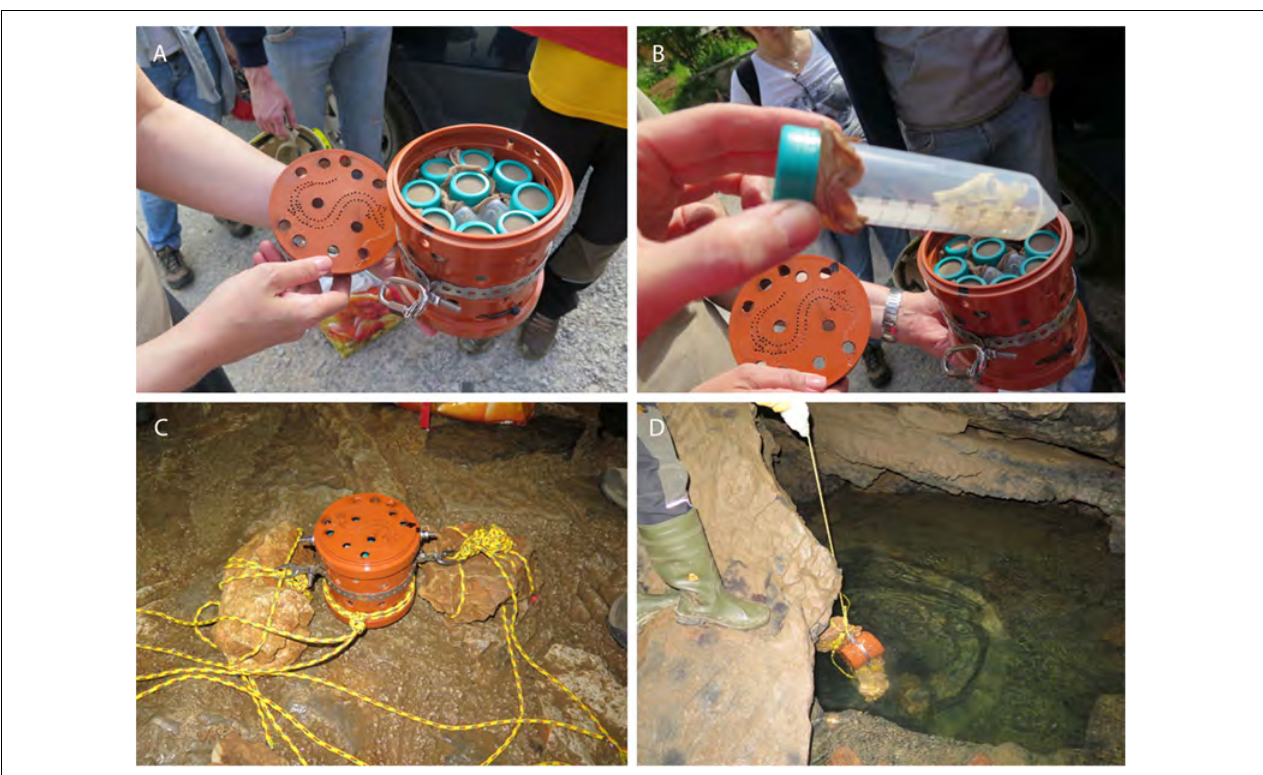
FIGURE 2 | Baits placed in Falcon tubes, closed with nylon textile, protected by perforate plastic container, firmly fixed into cave water by